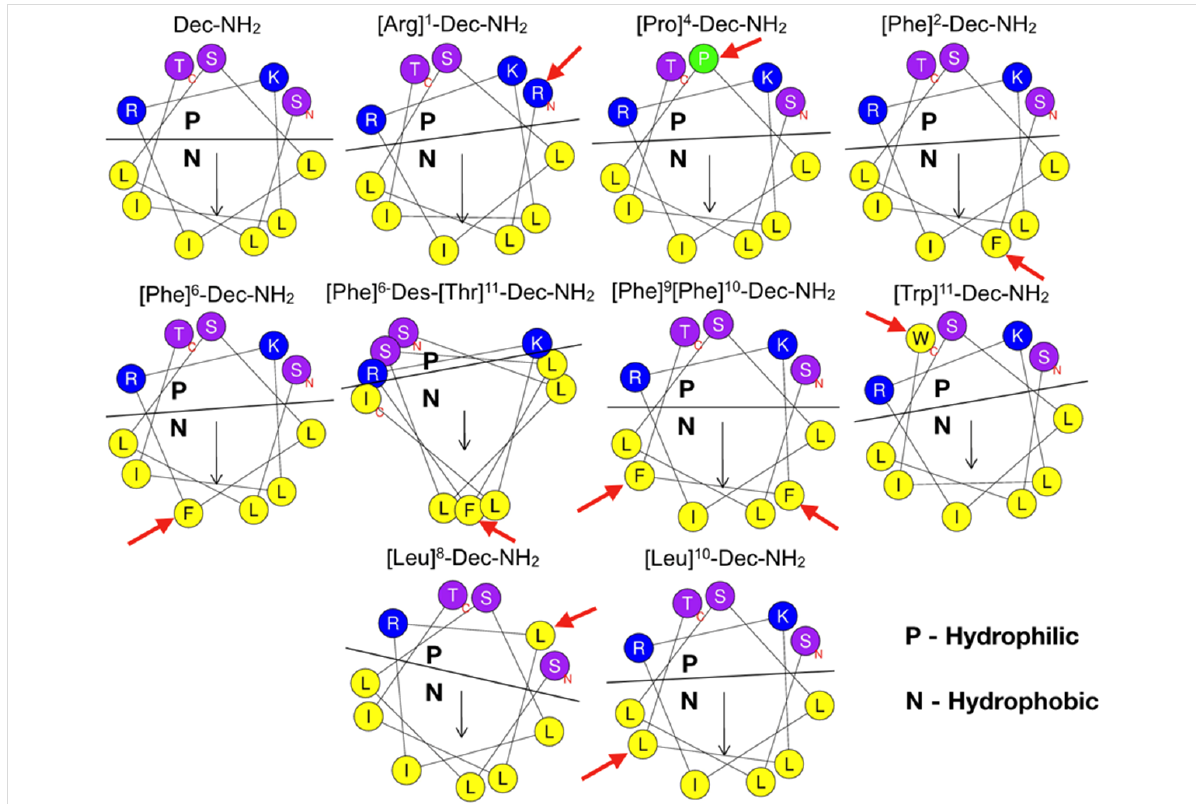
Figure 1: Helical wheel projections of Dec-NH 2 and its analogs, where the yellow circles refer to the hydrophobic amino acid residues, the blue ones to the cationic charged residues, the purple circles to the polar uncharged residues and the green circle to a proline residue. The black line denotes hydrophilic and hydrophobic faces of the amphipathic structures. Red arrows show the mutation positions.